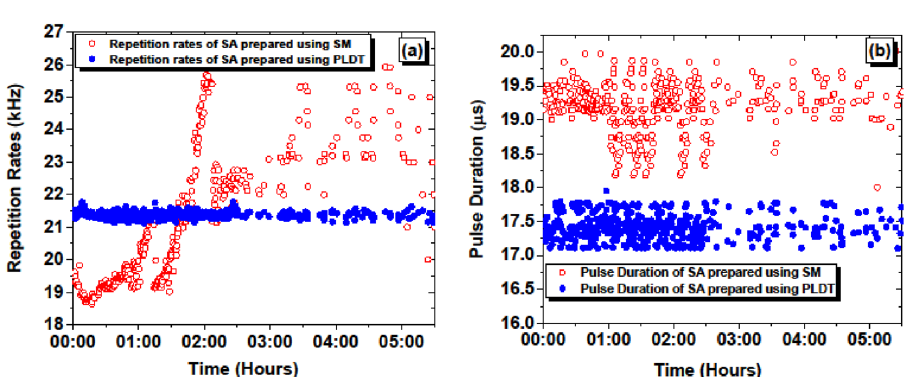
Figure 15. Measured ( a ) pulse repetition rates and ( b ) pulse duration as a function of time for SA prepared using SM and